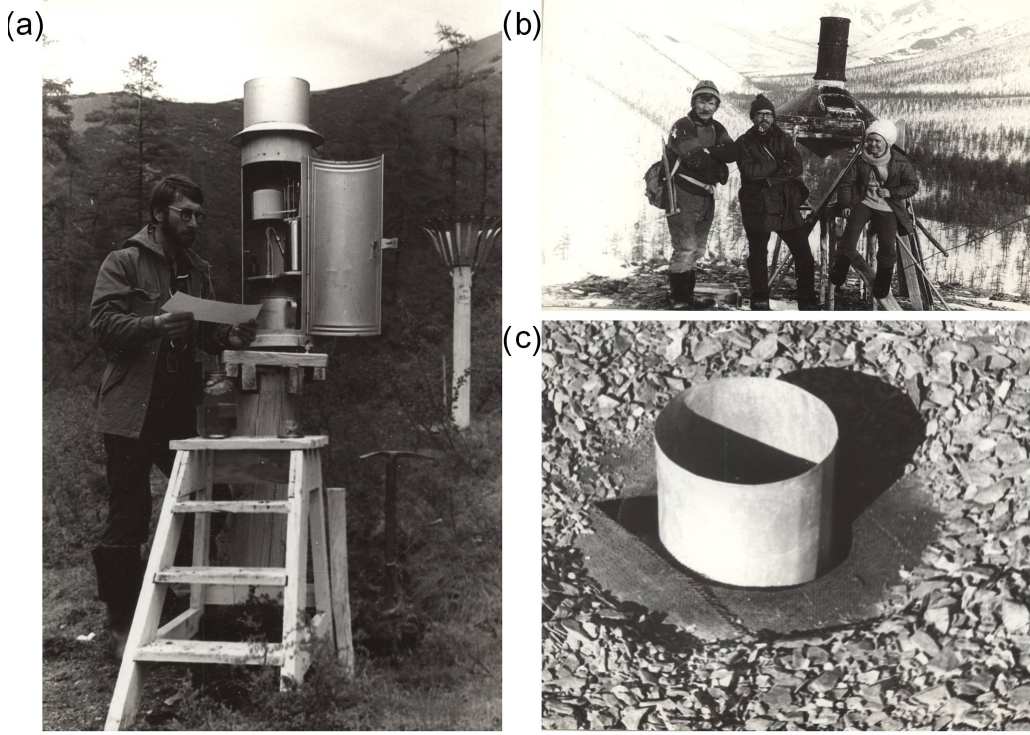
Figure 3. (a) Pluviometer, Tretyakov gauge; (b) Kosarev gauge; (c) remains of ground gauge GR-28 (Sushansky, 1988, 1989).